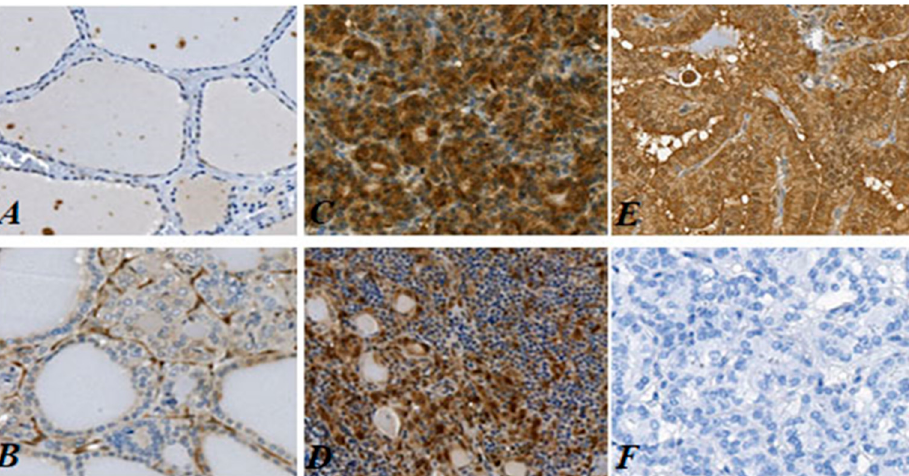
Figure 1. Histological IHC of Gal-3 expression in the tissue sections of Benign Nodules, NIFTP, in- vasive EFVPTC and LT tissues. ( A ). Lower detectable cytoplasmic Gal-3 expression was observed in the Benign Nodules tissue section. ( B ). Faint cytoplasmic Gal-3 immunostaining was detected in the NIFTP tissue section. ( C ). Moderate to strong cytoplasmic Gal-3 expression was observed in EFVPTC with capsular invasion. ( D ). Mild to moderate cytoplasmic Gal-3 expression was observed in the stained tissue section of LT. ( E ). Positive control, a classic aggressive PTC stained with anti- Gal-3 antibody showed moderate to strong immunostaining. ( F ). Negative control, a classic PTC incubated with isotype specific IgG in place of the anti-Gal-3 antibody did not show detectable im- munostaining. All images were shown at original magnification ×200. All images were shown at original magnification ×200.